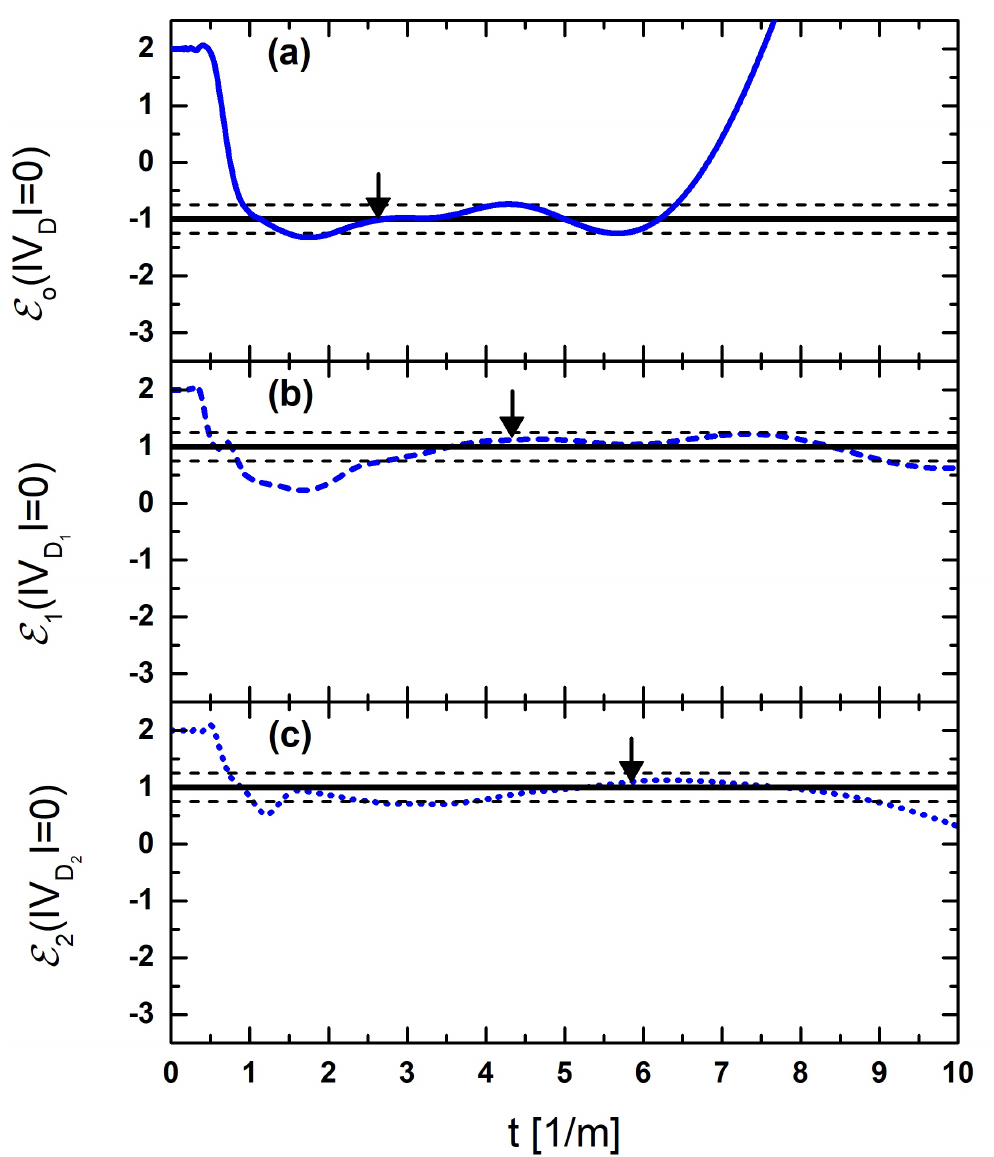
Figure 3. Generalized Euler characteristics calculated for the networks with the standard boundary conditions as a function of the parameter t . Panels ( a – c ) show the generalized Euler characteristics E o ( | V | = 0 ) (blue full line), E ( | V | = 0 ) (blue dashed line), and E D o D 1 1 line) of the networks Γ o ( 4,5,0 ) , Γ 1 ( 6,5,0 ) , and Γ 2 ( 4,3,0 ) , respectively. The plateaux at the plots of the generalized Euler characteristics shown in panels ( a – c ) start close to the points t 0 = 4.33 m − 1 , and t = 5.85 m − 1 , respectively, which are marked by the arrows. The black broken t 0 0 2 1 lines show the limits of the assumed maximum errors E o ( | V D | = 0 ) ± and E 2 ( | V D 2